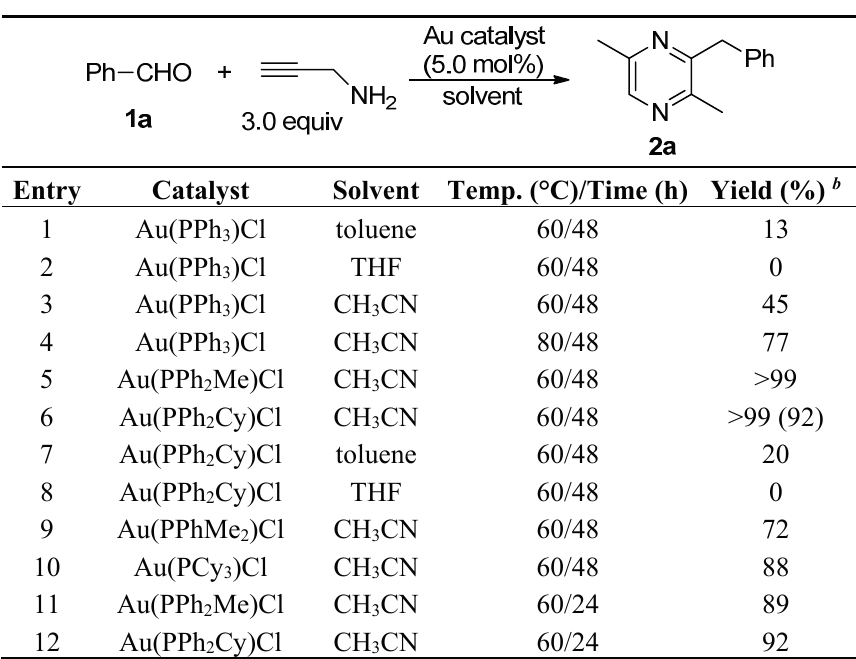
Table 1. Optimizing the reaction conditions for the formation of 3-benzyl-2,5- dimethylpyrazine ( 2a ) a